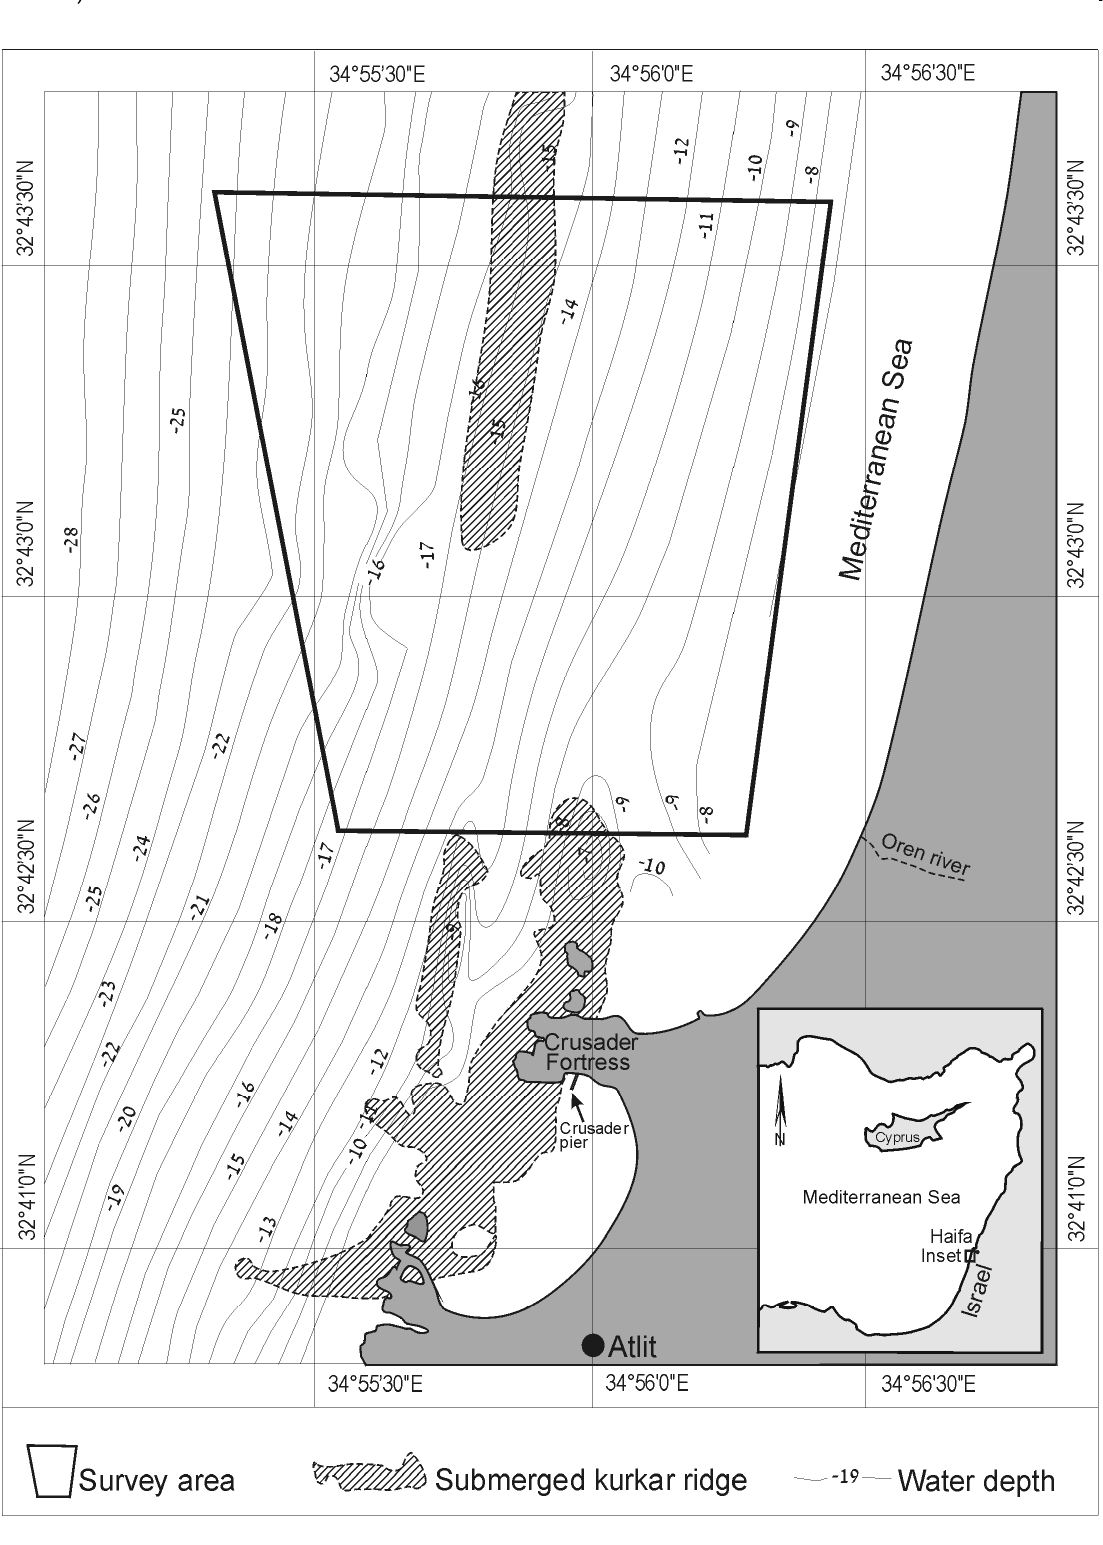
Figure 1. Location map of the East Mediterranean region and the Magnetic survey